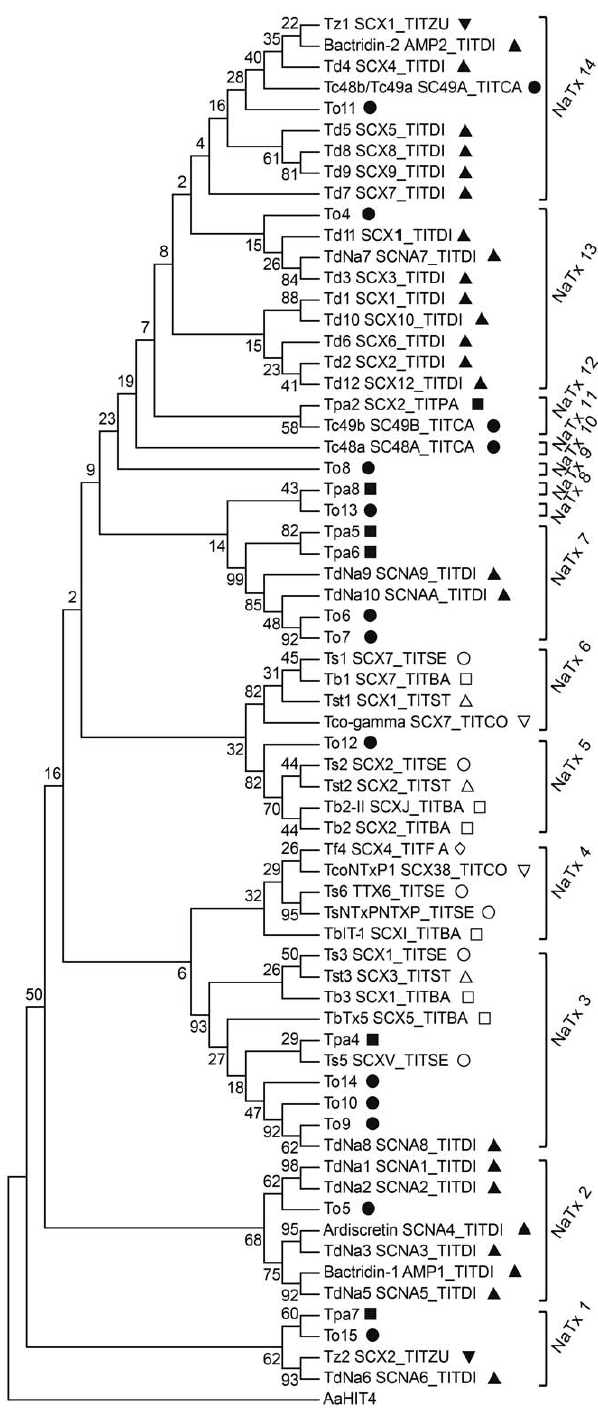
Figure 4. Phylogenetic analysis of NaScTxs from T.pachyurus , T. obscurus and other scorpions from Tityus genus. Filled symbols indicate toxins from scorpions inhabiting the Northern region of the Amazon Basin: square for T. pachyurus , circle for T. obscurus , triangle for T. discrepans , and inverted triangle for T. zulianus toxins. Open symbols indicate toxins from scorpions inhabiting the Southern part of the Amazon Basin: square for T. bahiensis , triangle for T. stigmurus , inverted triangle for T.costatus , circle for T. serrulatus , and rhombus for T. fasciolatus toxins.